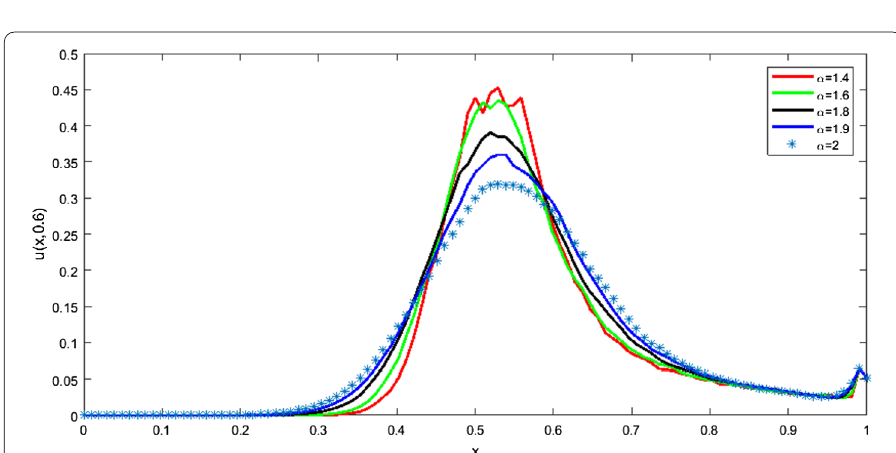
Figure 6 An approximate solution with β = 0.4 and α =